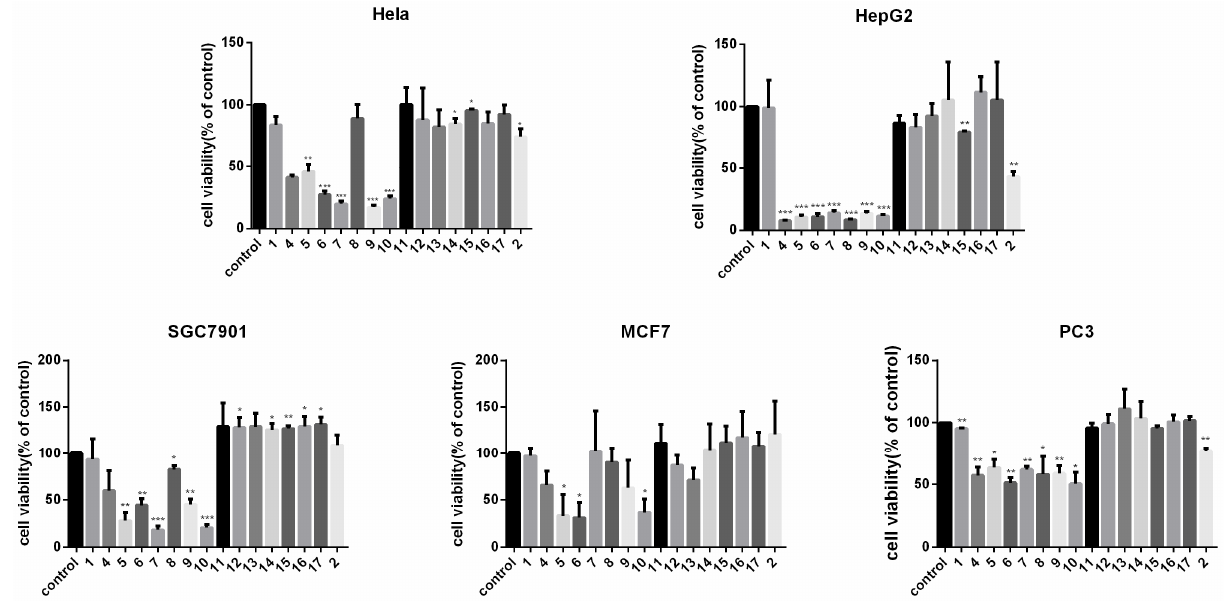
Figure 2. Cell viability suppression effect of AA derivatives on the A549, B16F10, HeLa, HepG2, SGC7901, MCF7, and PC3 cells. Cells were treated with 10 μ M compounds for 72 h and the cell viability was measured. * p < 0.05, ** p < 0.01, *** p < 0.001.